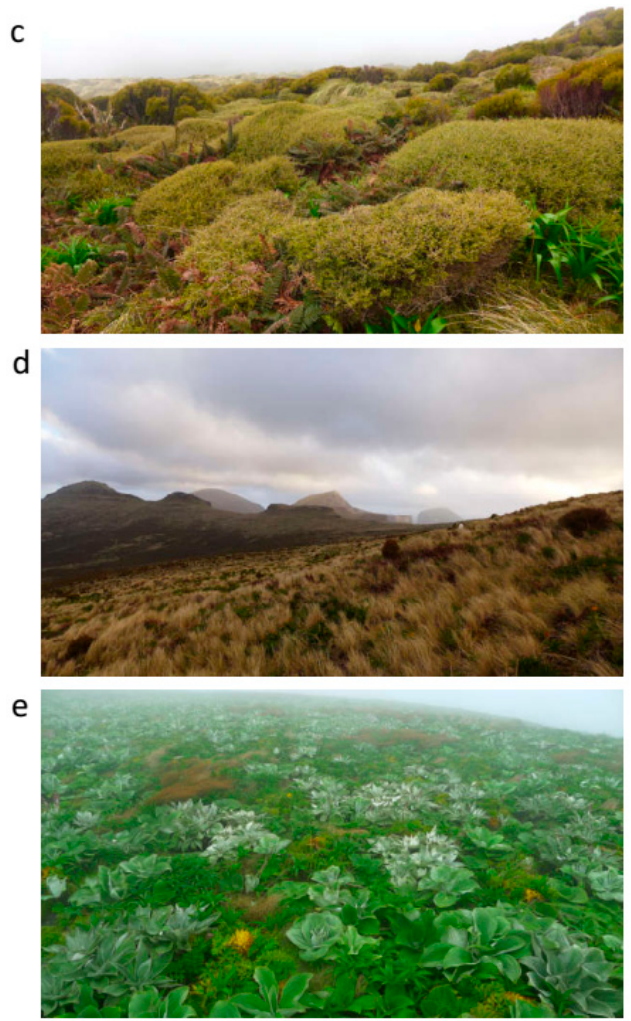
Figure 2. Main vegetation types on Campbell Island. Tree line Dracophyllum at 30 m a.s.l. near the head of Perseverance Inlet ( a ), Oreobolus cushion bog, c. 40 m ( b ), Myrsine and Coprosma shrubland,